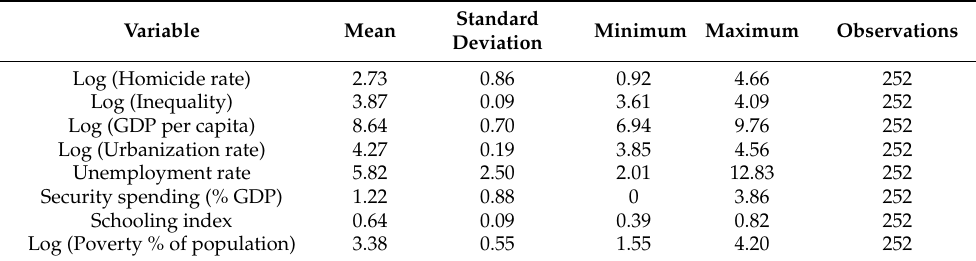
Table 2. Descriptive statistics of the